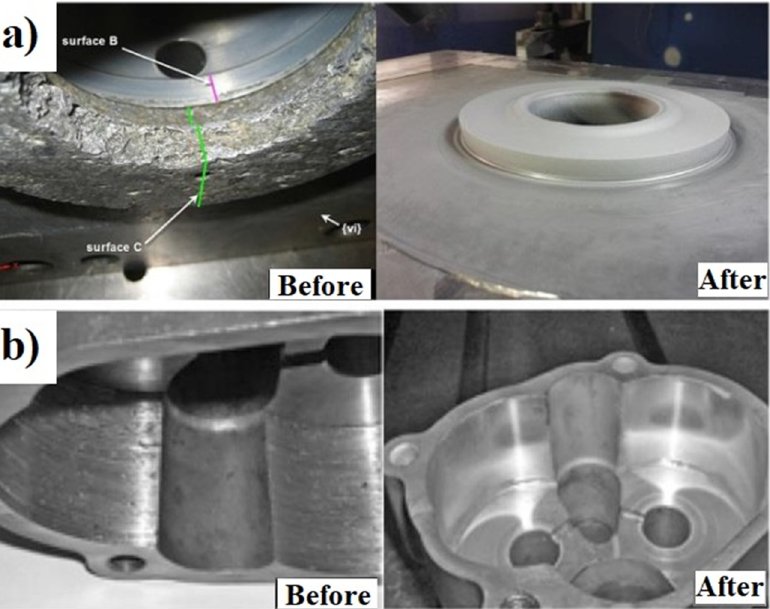
Figure 19: Comparing the deteriorated and restored parts by CSAM: ( a ) inner bore surface of a navy valve actuator and ( b ) oil pump housing of Caterpillar engine [ 72 ]